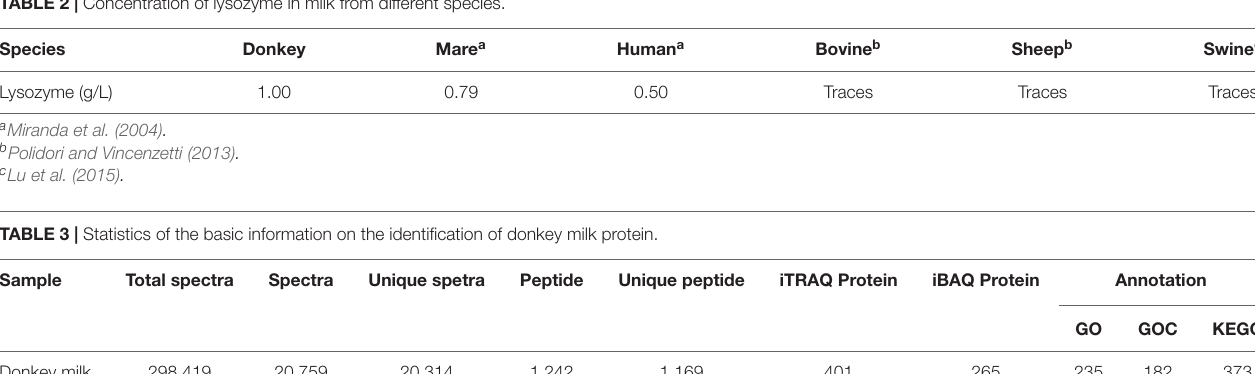
FIGURE 4 | mRNA and protein expression levels of the lysozyme gene family. (A) RNA expression of the lysozyme family genes among tissues and protein expression of lysozyme family in donkey milk. The dark green bar represents goose-type lysozyme, and the green bar represents chicken or conventional-type lysozyme. The dark blue bars on the right represent log10-transformed intensity-based absolute quantification iBAQ values of lysozyme proteins in donkey milk. (B) Overlap analysis of milk proteins across species. The left y -axis represents the number of overlapping or non-overlapping proteins, and the right y -axis represents the proportion of overlapping proteins to total proteins. TABLE 2 | Concentration of lysozyme in milk from different species.